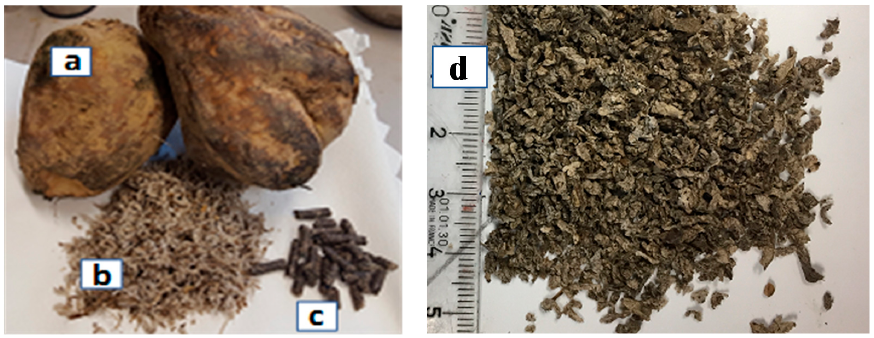
Figure 2. ( a ) Sugar beet fruit; ( b ) fresh sugar beet pulp; ( c ) extruded beet pulp pellets and ( d ) dried extruded beet pulp.